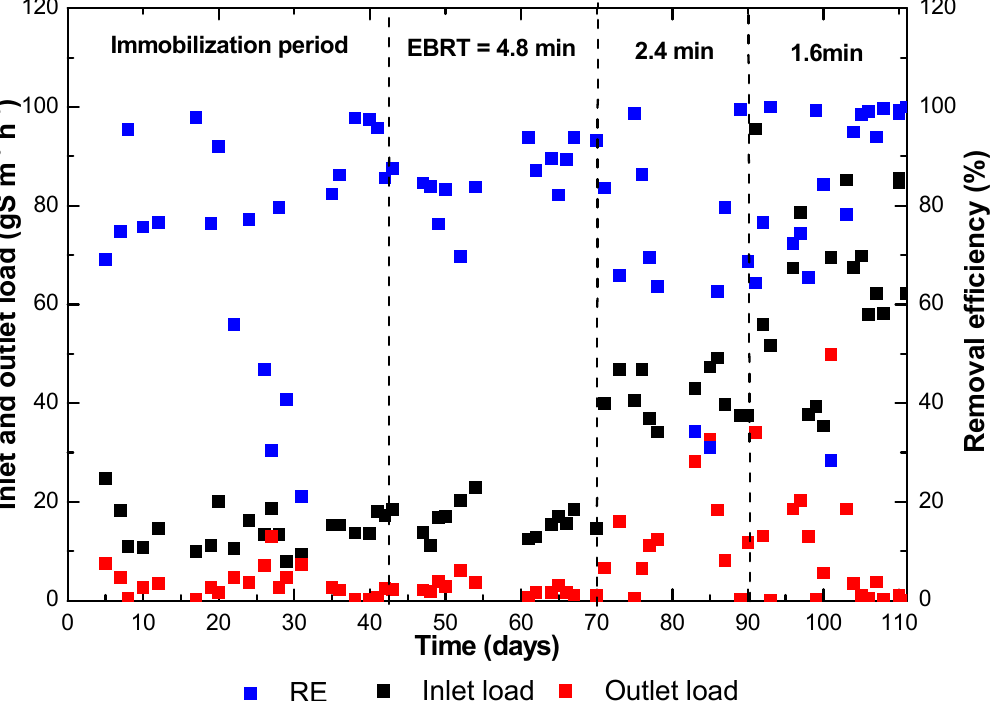
ChemEngineering 2018 , 2 , x FOR PEER REVIEW Figure 5. Removal efficiency and inlet and outlet loads during 111 days of biotrickling filter operation.